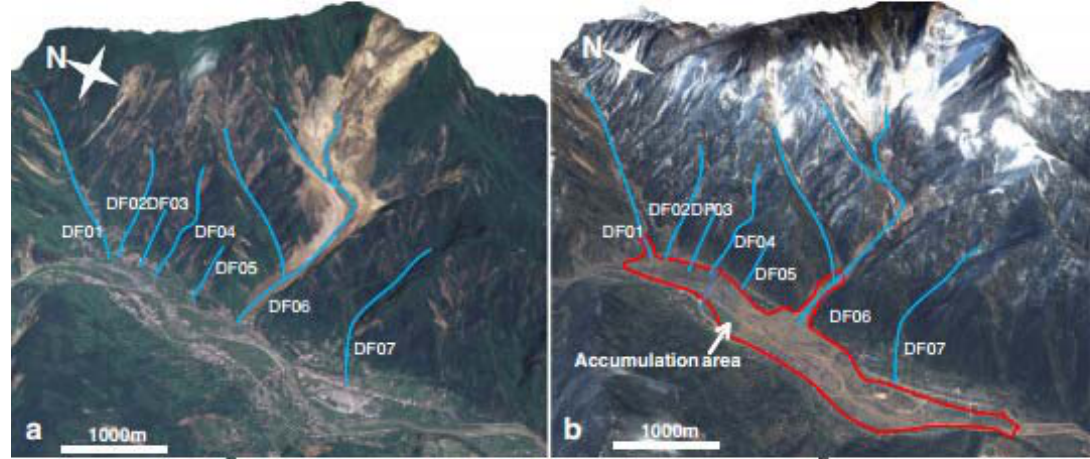
Figure 4. Images of the 13 August 2010 debris flow in Qingping Town: ( a ) aerial photo taken on 18 May 2008; and ( b ) a Worldview image from 13 December 2010.